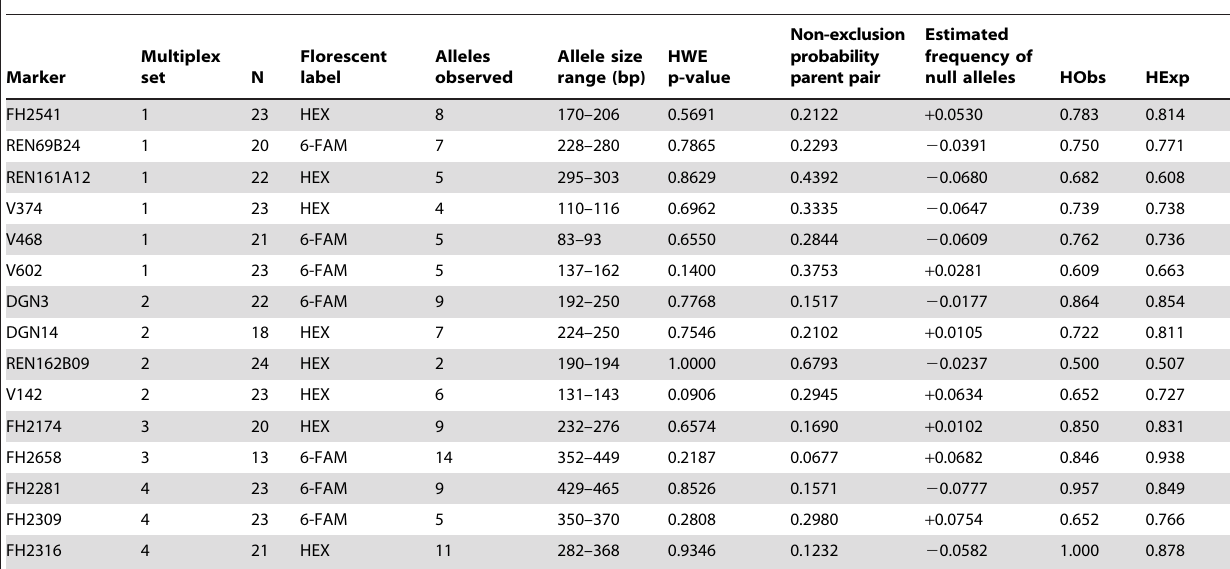
Table 2. Characterisation of 15 microsatellite markers in 24 unrelated foxes from Bristol’s high-density population.